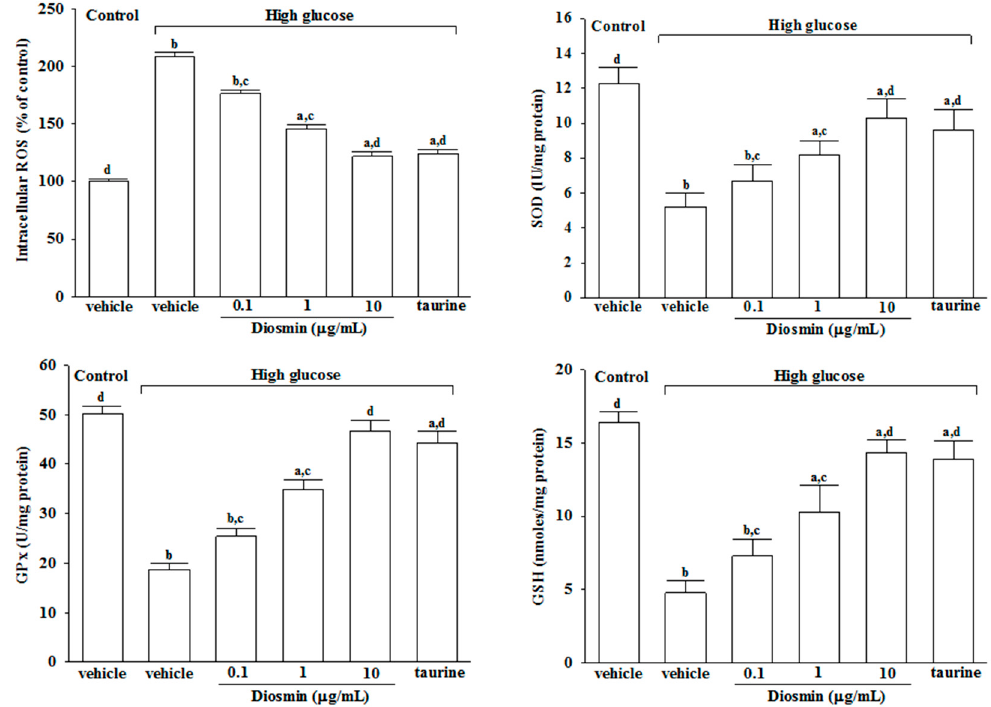
Figure 2. Effect of diosmin on the ROS generation and the antioxidant biomolecules in high glucose cultured ARPE-19 cells. The results are presented as the mean ± SD of five independent experiments in each column. a p < 0.05 and b p < 0.01 compared with normal-glucose vehicle-treated group (control), respectively. c p < 0.05 and d p < 0.01 compared with high-glucose vehicle-treated group, respectively.